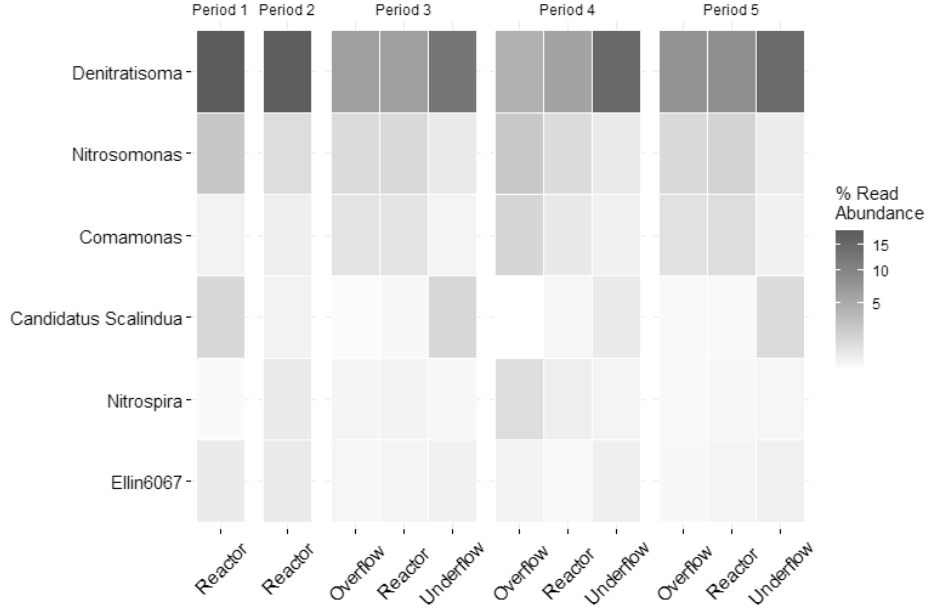
Figure 5. Dilution rate by anammox (AMX) (black circles with black trendline), ammonia-oxidiz- ing bacteria (AOB) (grey triangle with grey line), nitrite-oxidizing bacteria (NOB) (white cubes with black dashed line), versus solids retention time of the suspended sludge continuous stirred tank reactor with hydrocyclone. The R-square was 0.6, 0.8, and 0.9 for AMX, AOB, and NOB, re- spectively.